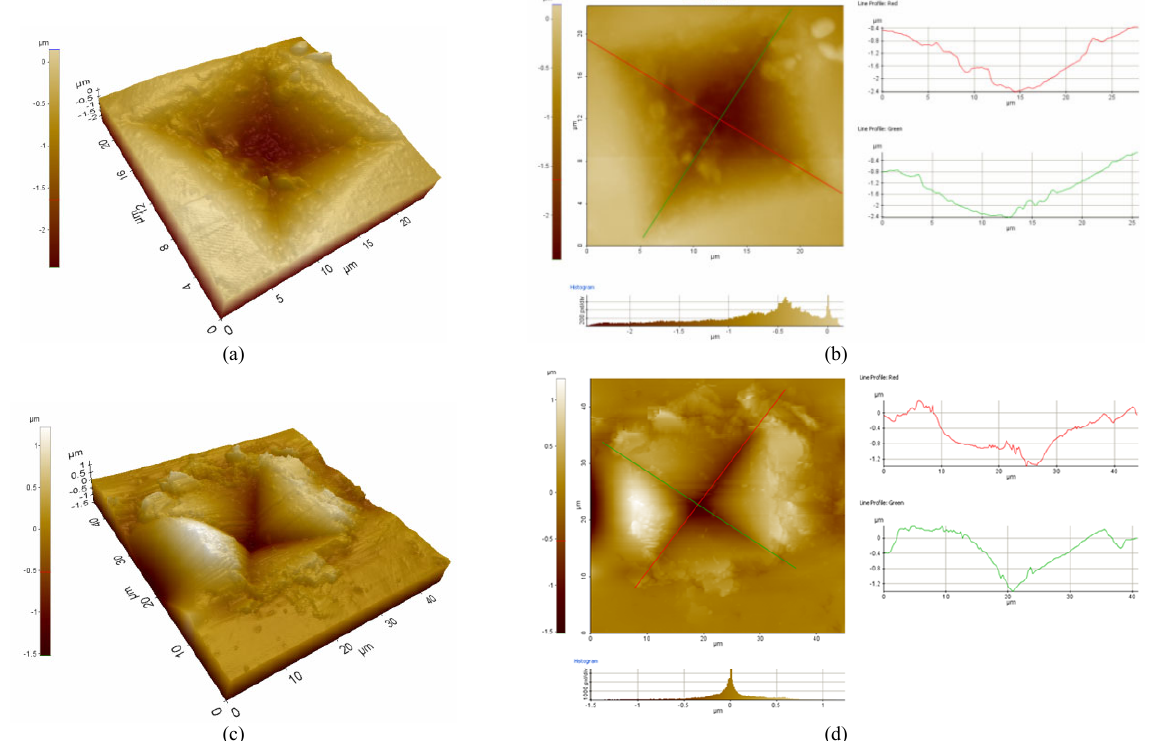
Fig. 11 AFM images of the Vickers indentation marks under a charge of 5 N for the bulk material obtained after sintering at (a, b) 1300 ℃ for 10 min and (c, d) 1400 ℃ for 20 min.